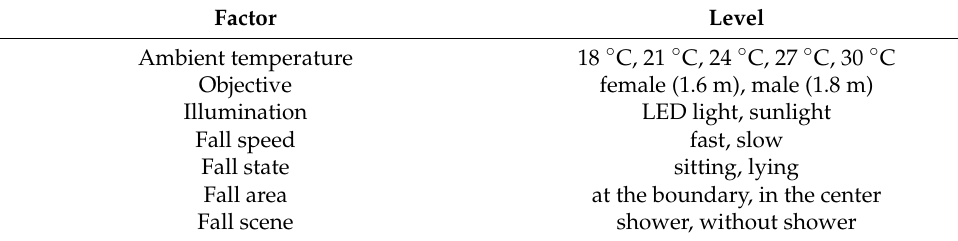
Table 1. Key factors for bathroom fall